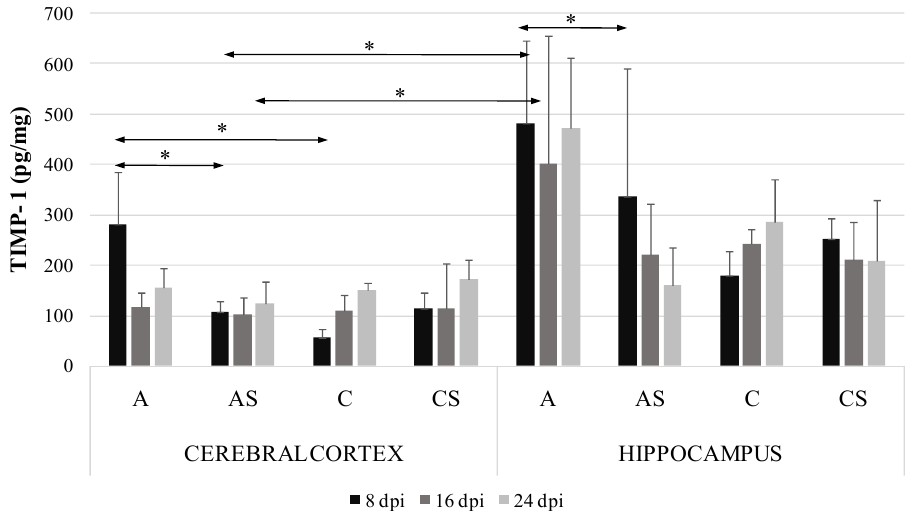
Figure 3. Tissue inhibitors of metalloproteinase-1 (TIMP-1) level (pg/mg protein) in the cerebral cortex and hippocampus in control and infected groups at 8, 16 and 24 days post Acanthamoeba spp.